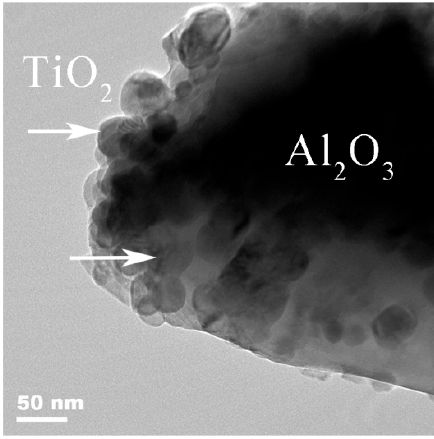
Figure 4. TEM image of alumina particles surface with 0.4 wt.% TiO 2 added.